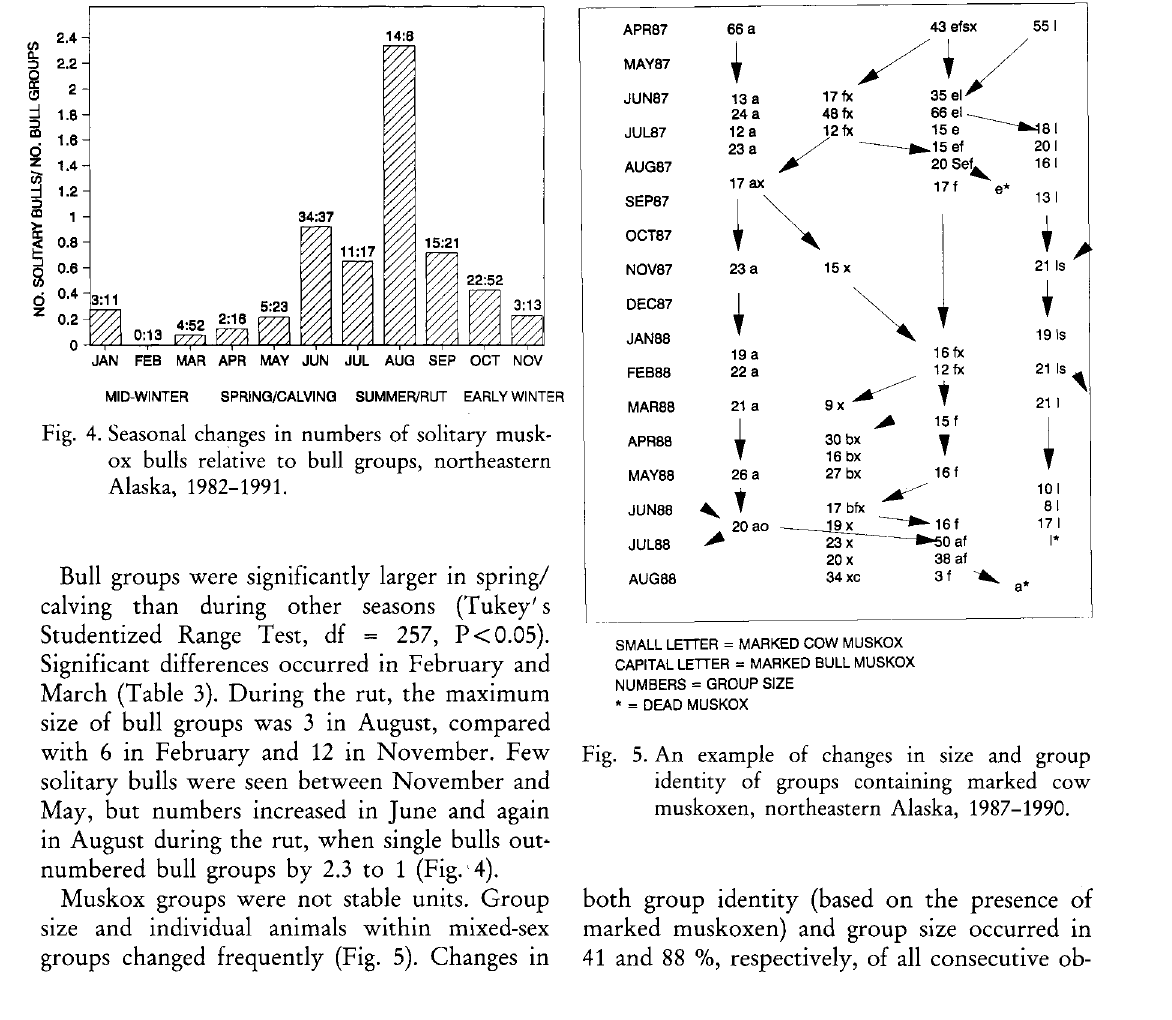
Table 3. Seasonal chan^ ;e in the average size of muskox bull groups in northeastern Alaska, 1982-1991. Month N Mean